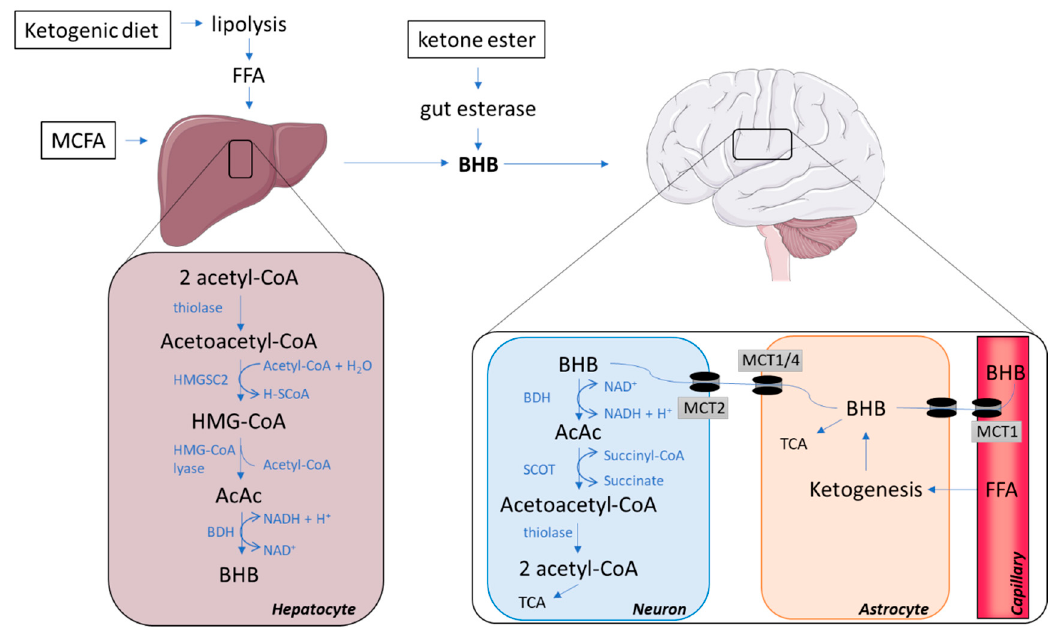
Figure 1. Pathways involved in synthesis and catabolism of ketone bodies. AcAc, acetoacetate; Acetyl-CoA, acetyl coenzyme A; BHB, beta-hydroxybutyrate; BHD, beta-hydroxybutyrate dehydrogenase; FFA, free fatty acids; HMG-CoA, 3-hydroxy-3-methylglutaryl-CoA; HMGCS2, 3-Hydroxy-3-Methylglutaryl-CoA Synthase 2; MCFA, medium-chain fatty acids; MCT, monocarboxylate transporter; SCOT, succinyl-CoA:3-ketoacid Coenzyme A transferase; TCA, tricarboxylic acid cycle.